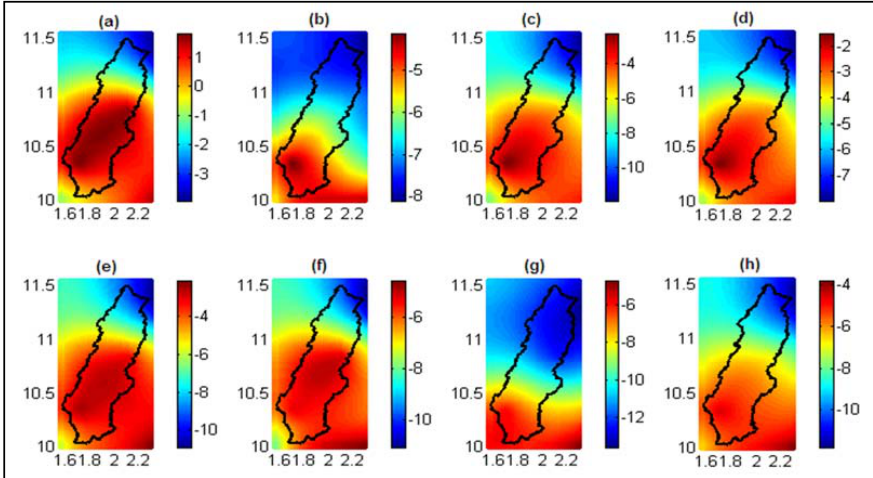
Figure 5 . Changes in the number of wet days (%) compared to the reference period a : RCP4.5 ‐ 2011– 2040; b : RCP4.5 ‐ 2041–2070; c : RCP4.5 ‐ 2071–2100; d : RCP4.5 ‐ 2011–2100; e : RCP8.5 ‐ 2011–2040; f : RCP8.5 ‐ 2041–2070; g : RCP8.5 ‐ 2071–2100; h : RCP8.5 ‐ 2011–2100.